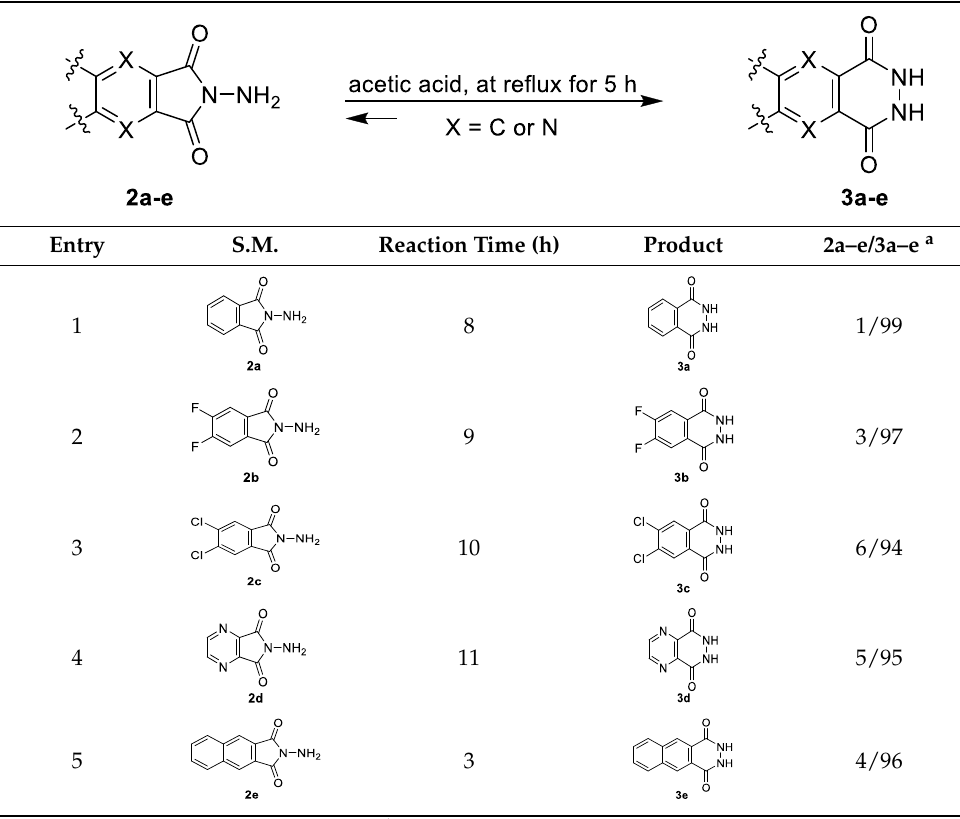
Entry S.M. Entry